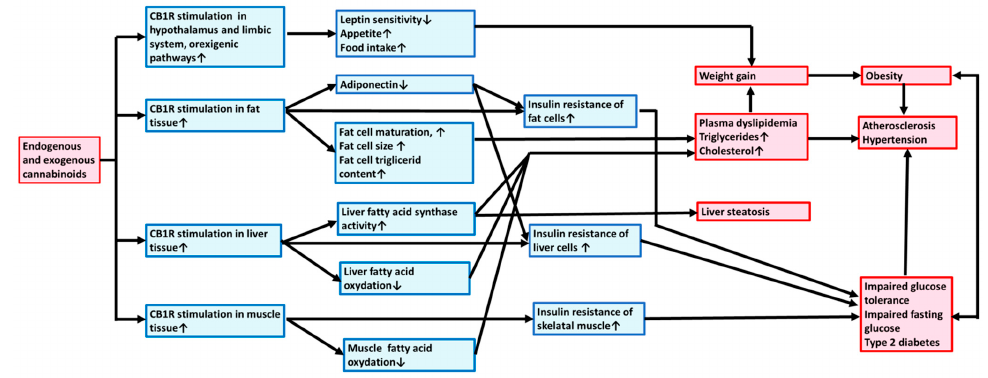
Figure 1. Exogenous and endogenous cannabinoids promote metabolic syndrome and atherosclerosis through central and peripheral type 1 cannabinoid receptors. Mechanism of action. Exogenous and endogenous cannabinoids via stimulation of CB 1 Rs activate orexigenic pathway, increasing appetite and stimulating fat, liver, and muscle tissues to promote lipogenesis, weight gain, and obesity. CB 1 R activation also induces alteration of lipid homeostasis elevating plasma triglyceride and cholesterol levels and thus increasing the risk for the development of atherogenesis, hypertension, and liver steatosis. In addition, CB 1 R activation by developing insulin resistance and gluconeogenesis may induce the risk for type 2 diabetes mellitus. CB 1 R, type 1 cannabinoid receptor.